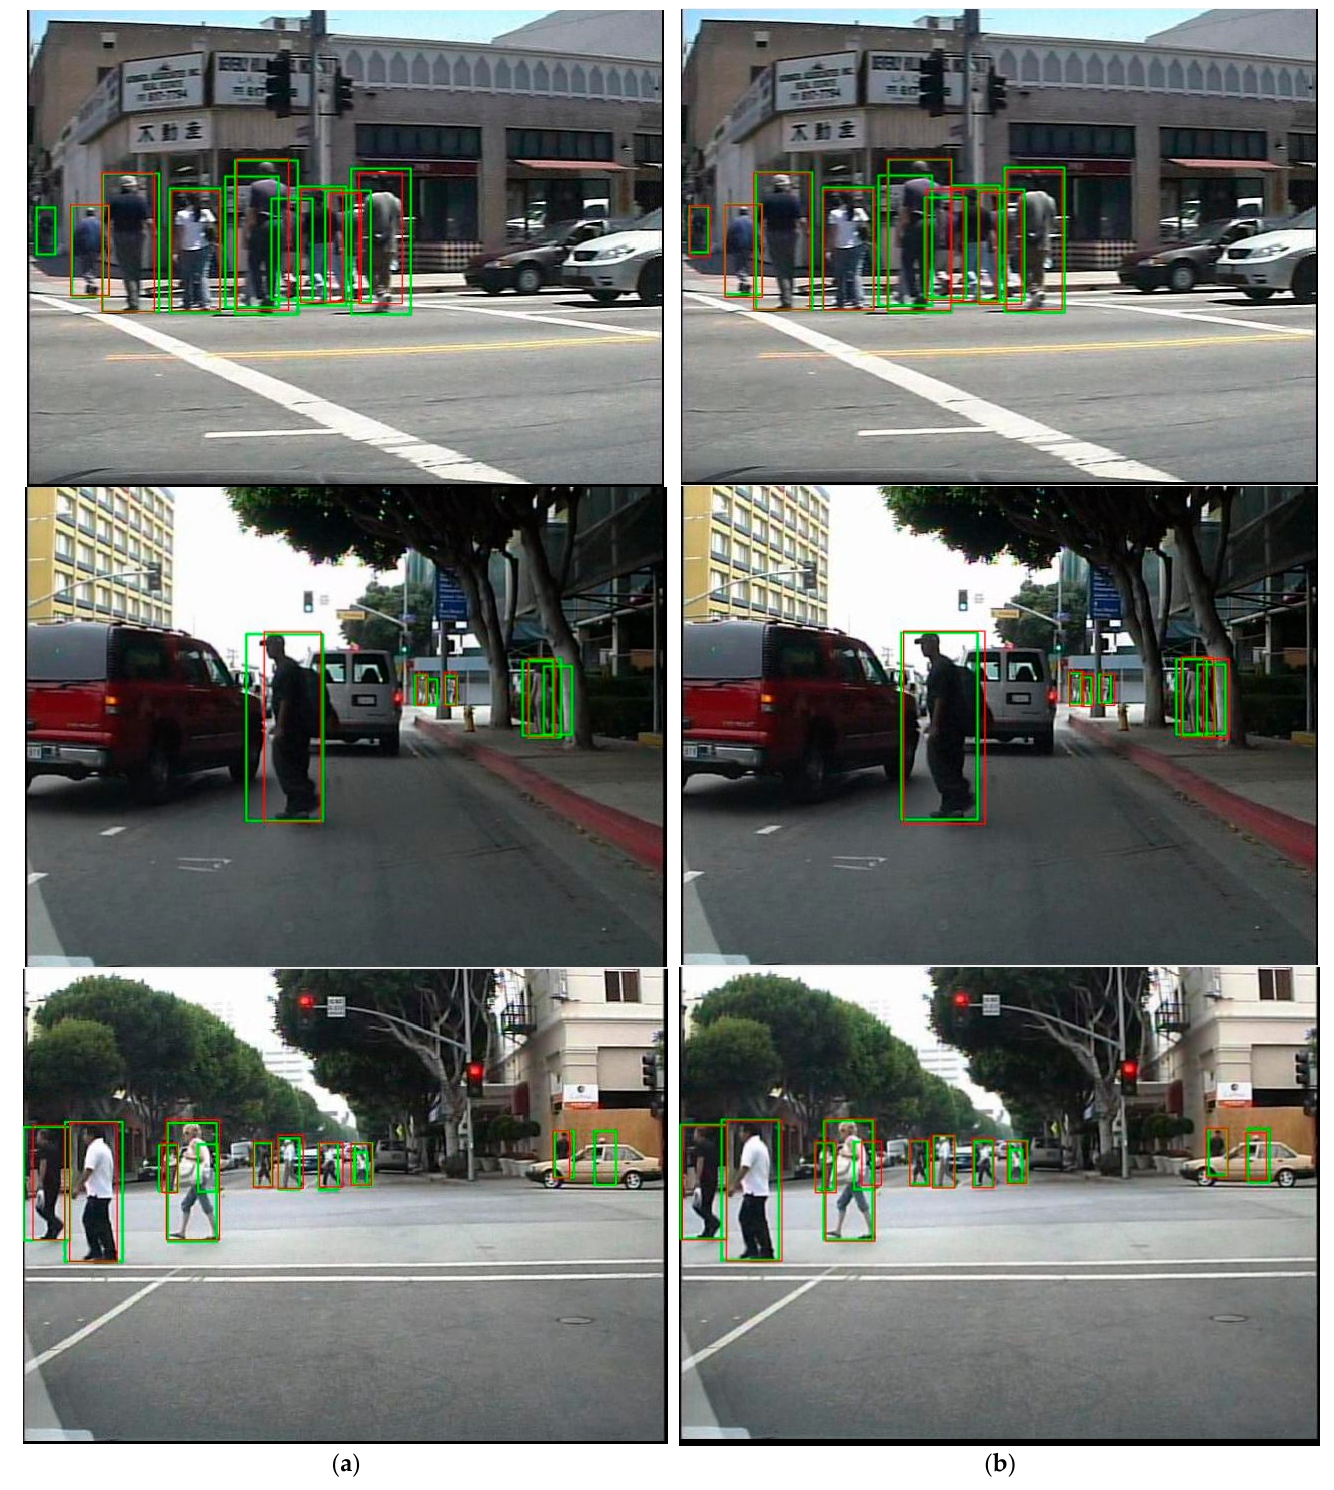
Figure 8. Example detection results of our proposed DAGN++ method compared with those of the Pedestron method of Caltech test set. ( a ) Pedestron [42] and ( b ) DAGN++ (ours). Green boxes, ground truth and red boxes, detection results. We visualized the detection boxes with the confidence score larger than 0.3.